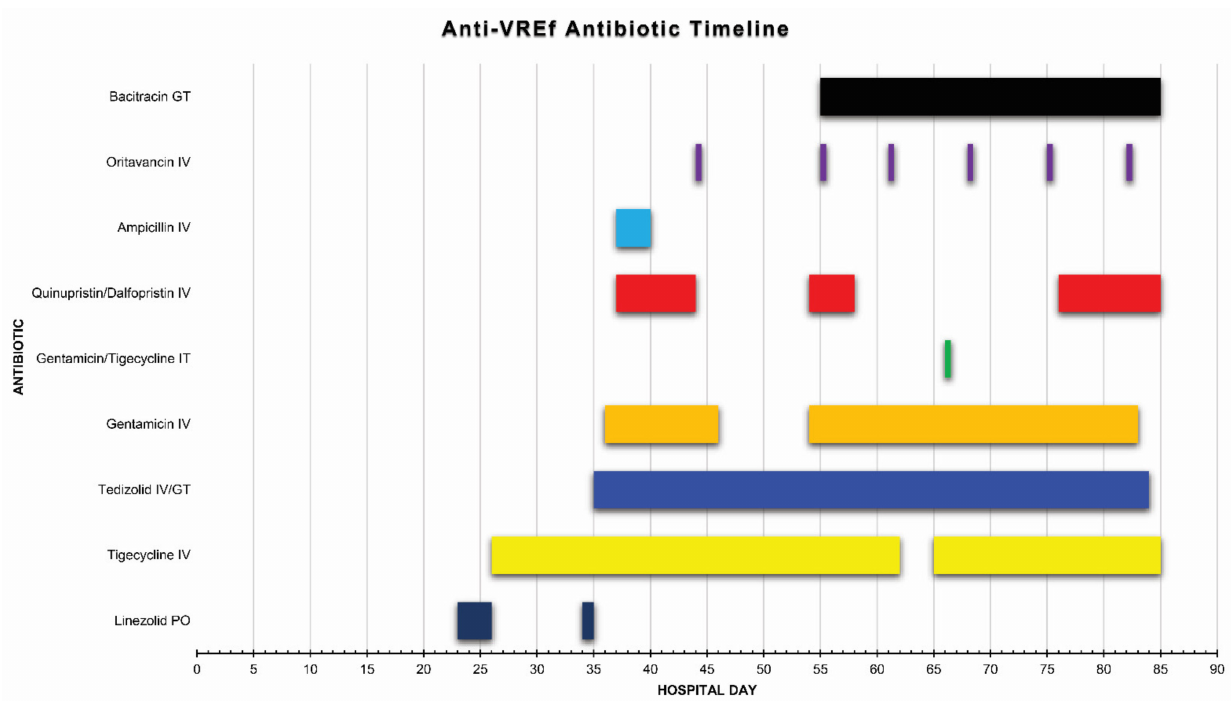
Figure 2. Timeline of antimicrobial regimens administered for the treatment of VREf bacteremia and meningitis throughout the hospital admission. GT, gastrostomy tube; IV, intravenous; IT, intrathecal; PO, per